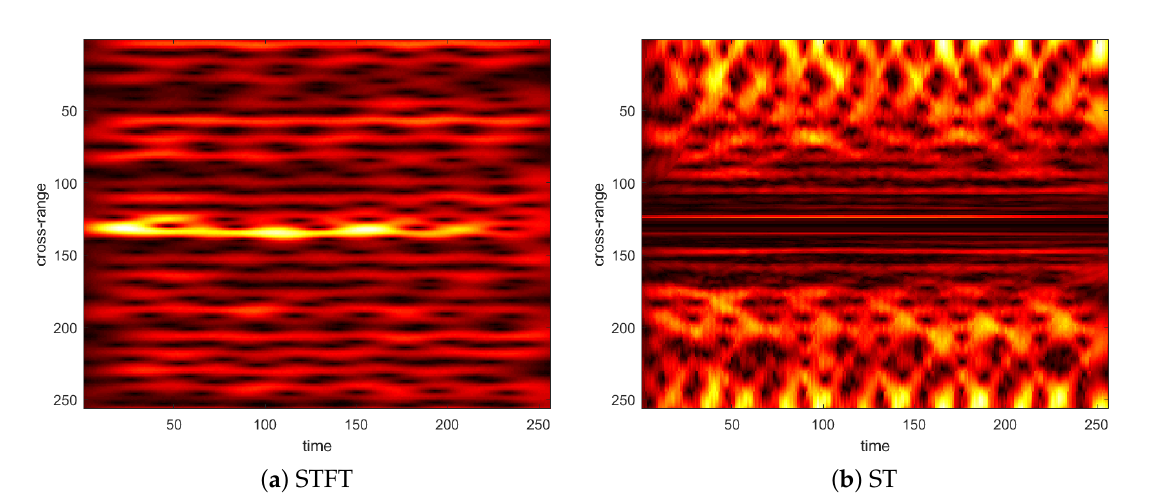
Figure 3. STFT and S-transform result of the same range